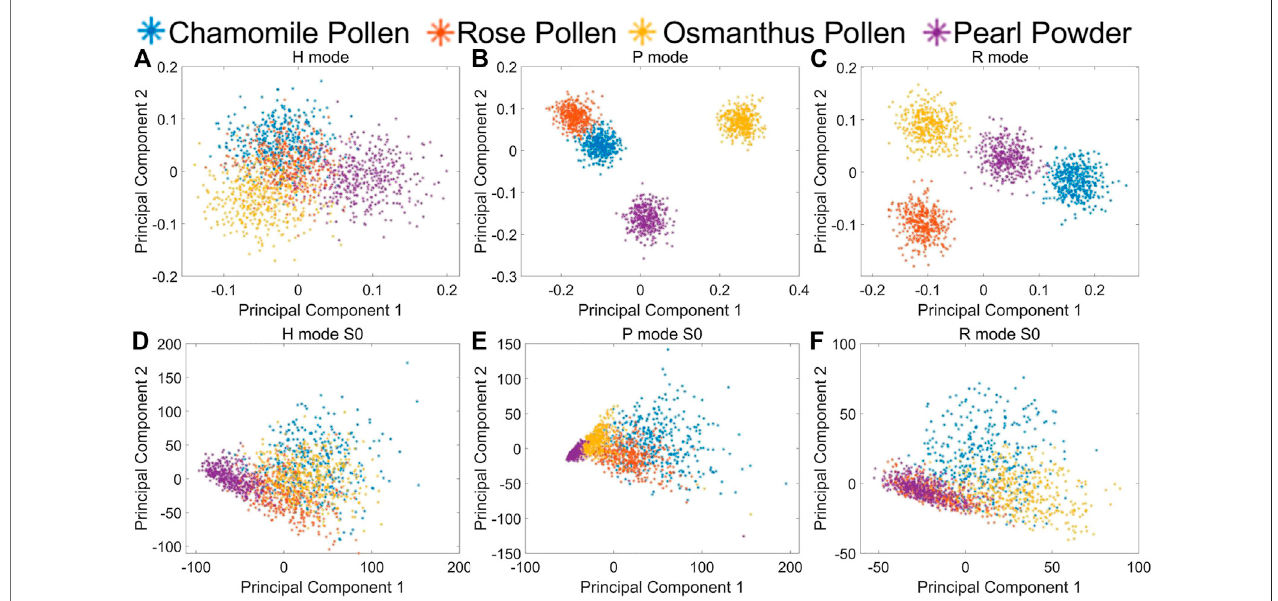
FIGURE6 | Biological samples on PCA fi rst and second principalcomponent. (A) MAPISunder H mode; (B) MAPISunderP mode; (C) MAPIS under Rmode. (D) S 0 at four angles under H mode; (E) S 0 at four angles under P mode; (F) S 0 at four angles under R mode.